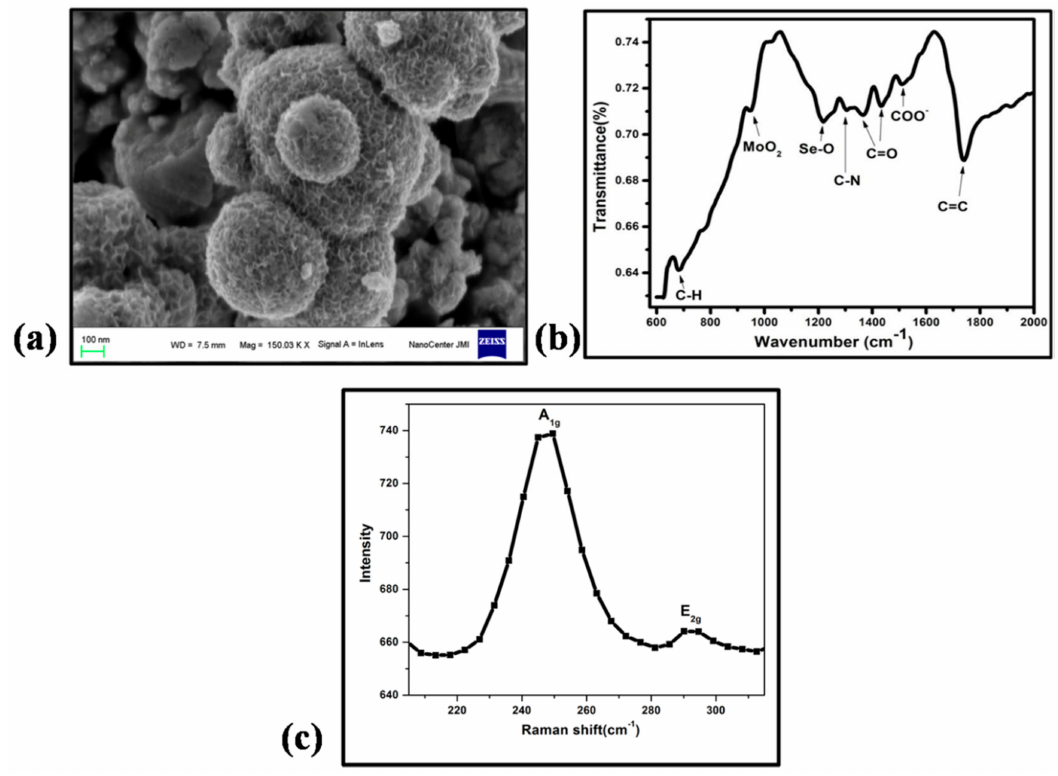
Figure 1. MoSe 2 Nanourchin ( a ) Scanning electron micrograph at 100 nm focusing urchin like morphology ( b ) FTIR spectrum ( c ) Raman